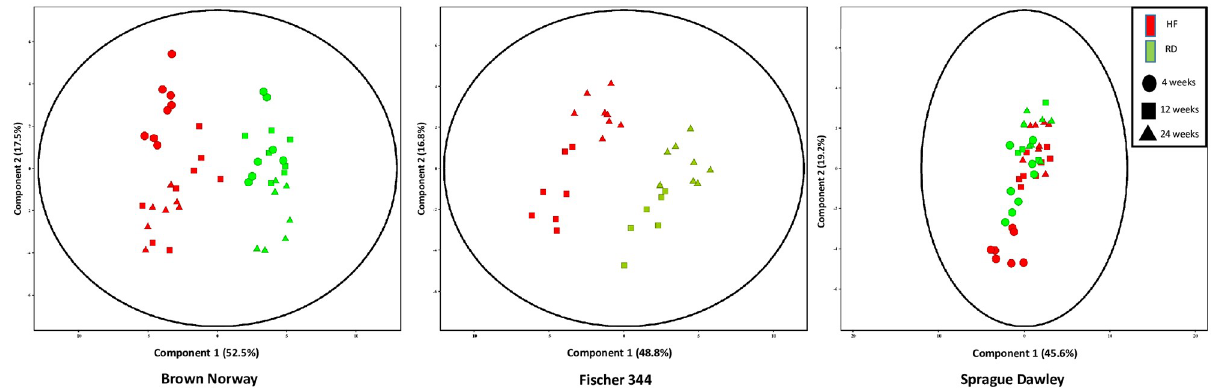
Fig 2. PCA scores plots obtained from UHPLC-Q ToF-MS data of the global liver metabolome from three rat strains fed either high fat (HF) or regular diet (RD) and at three different time points (4 weeks, 12 weeks, and 24 weeks). The area inside the ellipse region represents the 95% confidence